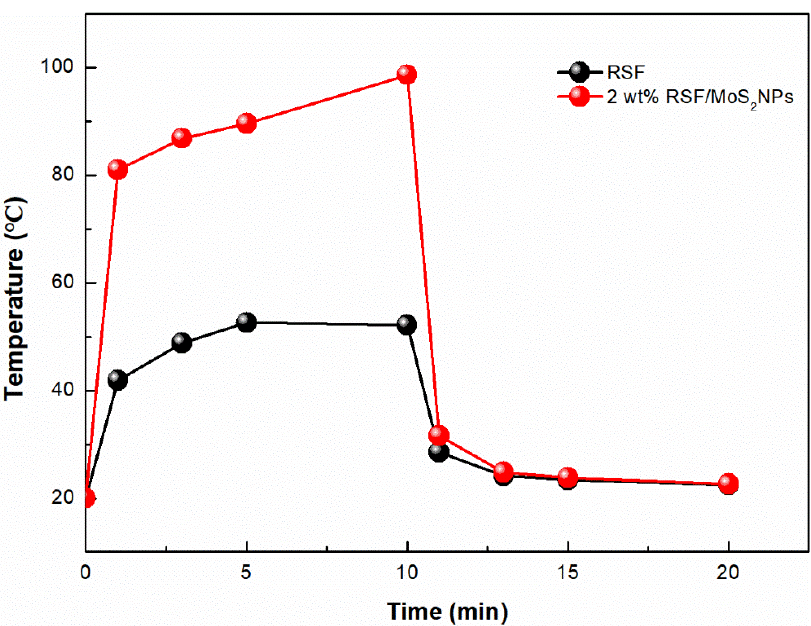
NPs hybrid fibers had good photothermal conversion performance in simulated sunlight, Figure 9. The temperature changes of 2 wt% RSF/MoS 2 NPs hybrid fibers during heating and cool- Figure 9. The temperature changes of 2 wt% RSF/MoS 2 NPs hybrid fibers during heating and cooling. and could be used as intelligent photothermal fibers with higher toughness. ing.